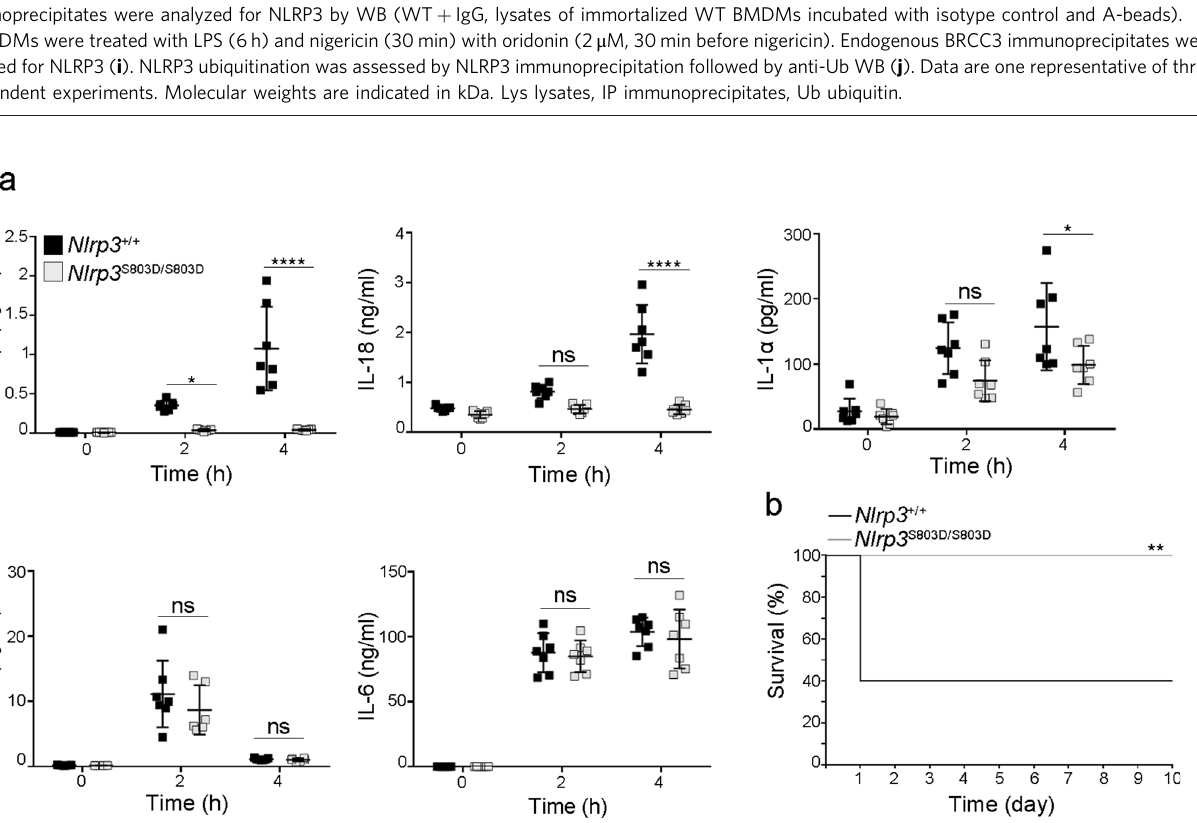
Fig. 6 Nlrp3 S803D/S803D KI mice show an impaired response to endotoxic shock in vivo. Nlrp3 S803D/S803D and Nlrp3 + / + littermates were injected intraperitoneally with LPS. a Indicated cytokines were measured in the sera collected before as well as 2 and 4 h post-injection. Nlrp3 S803D/S803D and Nlrp3 + / + ( n = 7). Individual values, means and 1 SD are represented, repeated measure two-way ANOVA with Sidak ’ s multiple comparisons of each condition with corresponding WT control; ns, non signi fi cant; * p -value < 0.05; **** p -value < 0.0001. b Mice survival to endotoxic shock. Nlrp3 S803D/S803D ( n = 11), Nlrp3 + / + ( n = 10), two-sided Mantel-Cox test, ** p -value < 0.01. Data are biological replicates of one